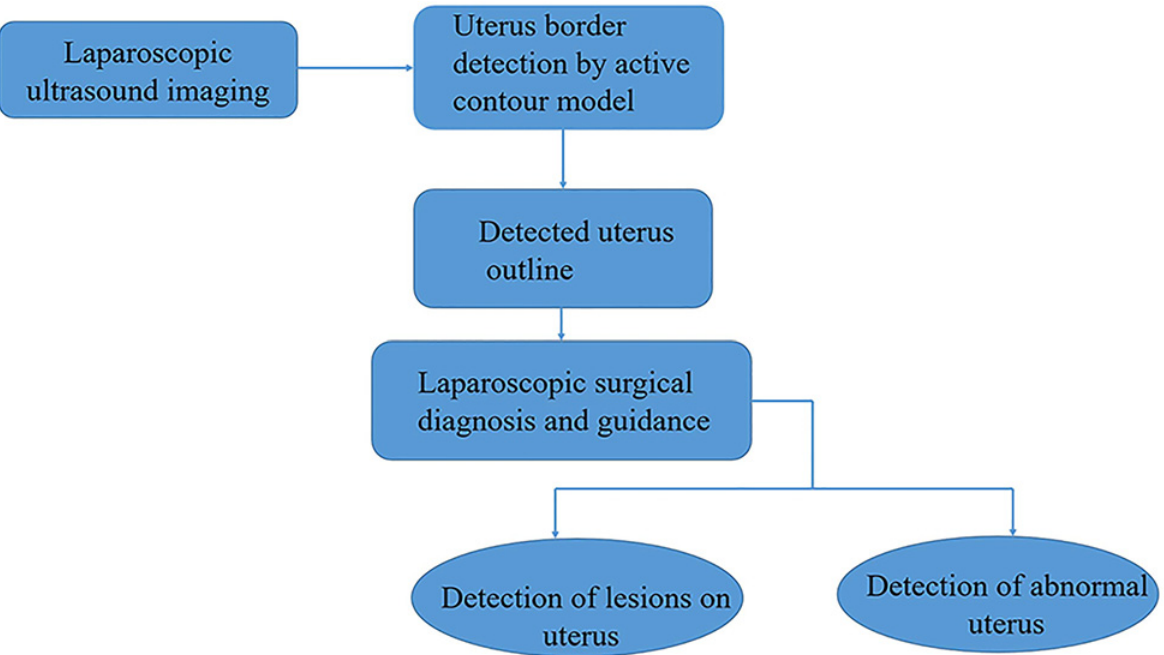
Fig 2. Classification of intra-operative laparoscopic ultrasound examination of 42 women subjects. The gynecological cases included: uterine fibroids (25 cases), congenital uterine malformations (4 cases), ovarian endometriomas (4 cases), pelvic adhesions masses (2 cases), ruptured ectopic pregnancies (2 cases), and small nodules biopsy on pelvic wall (1